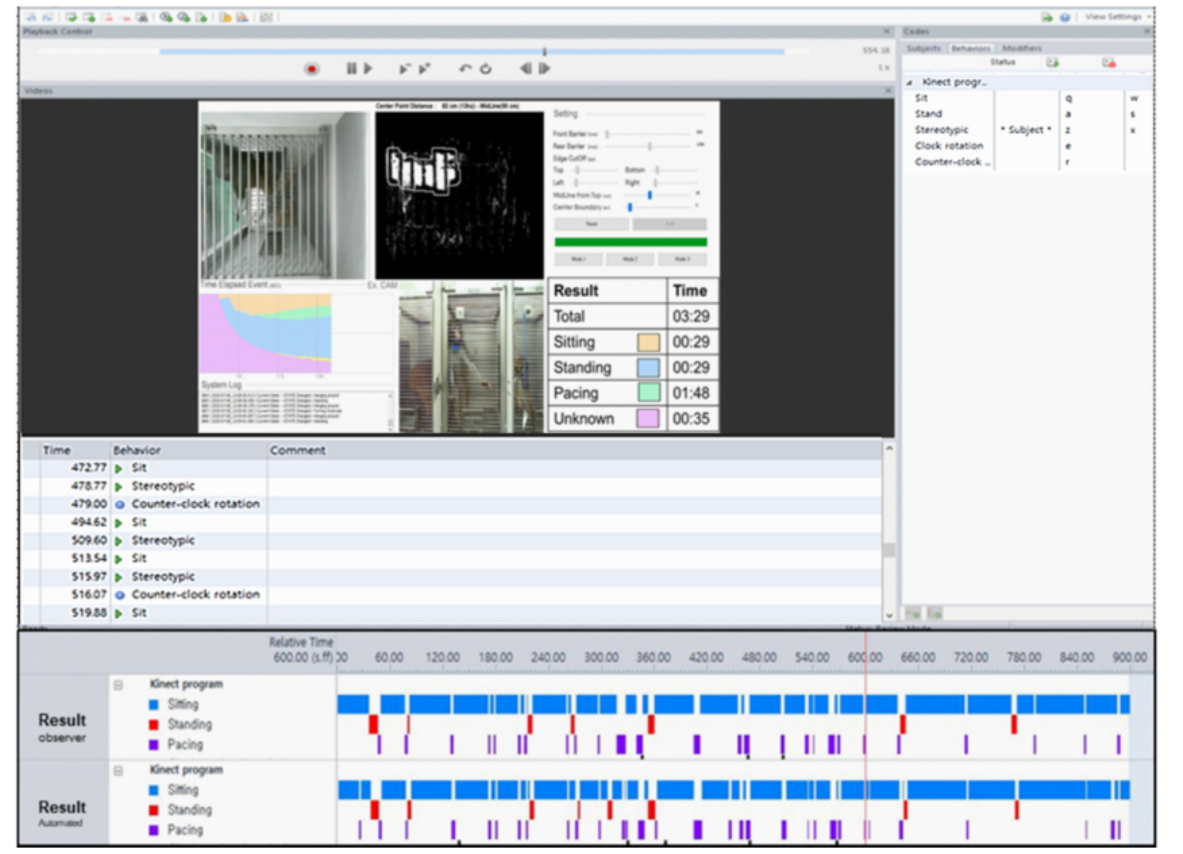
Figure 6. Program verification through Observer XT. Manual ratings of behaviors using Observer XT software and results including behavioral event and